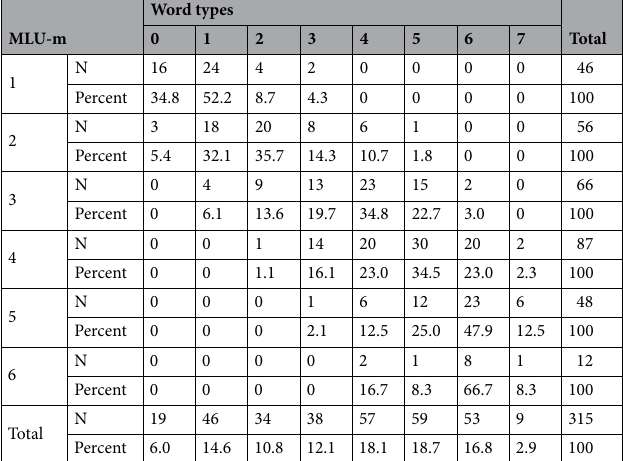
Table 7. Contingency tables of subject pronoun according to MLU-m.